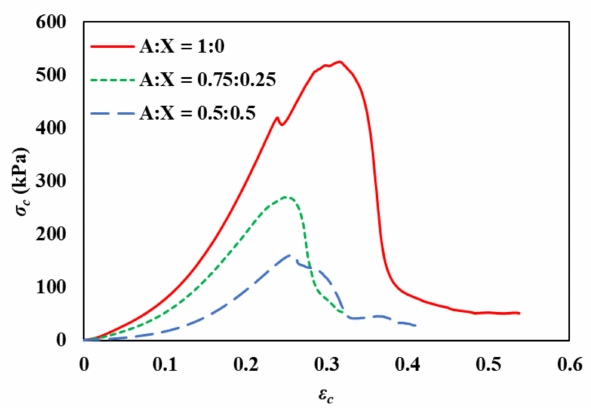
Figure 2. Representative stress-strain curves obtained by compression test for agarose-xanthan gel systems. A is agarose and X is